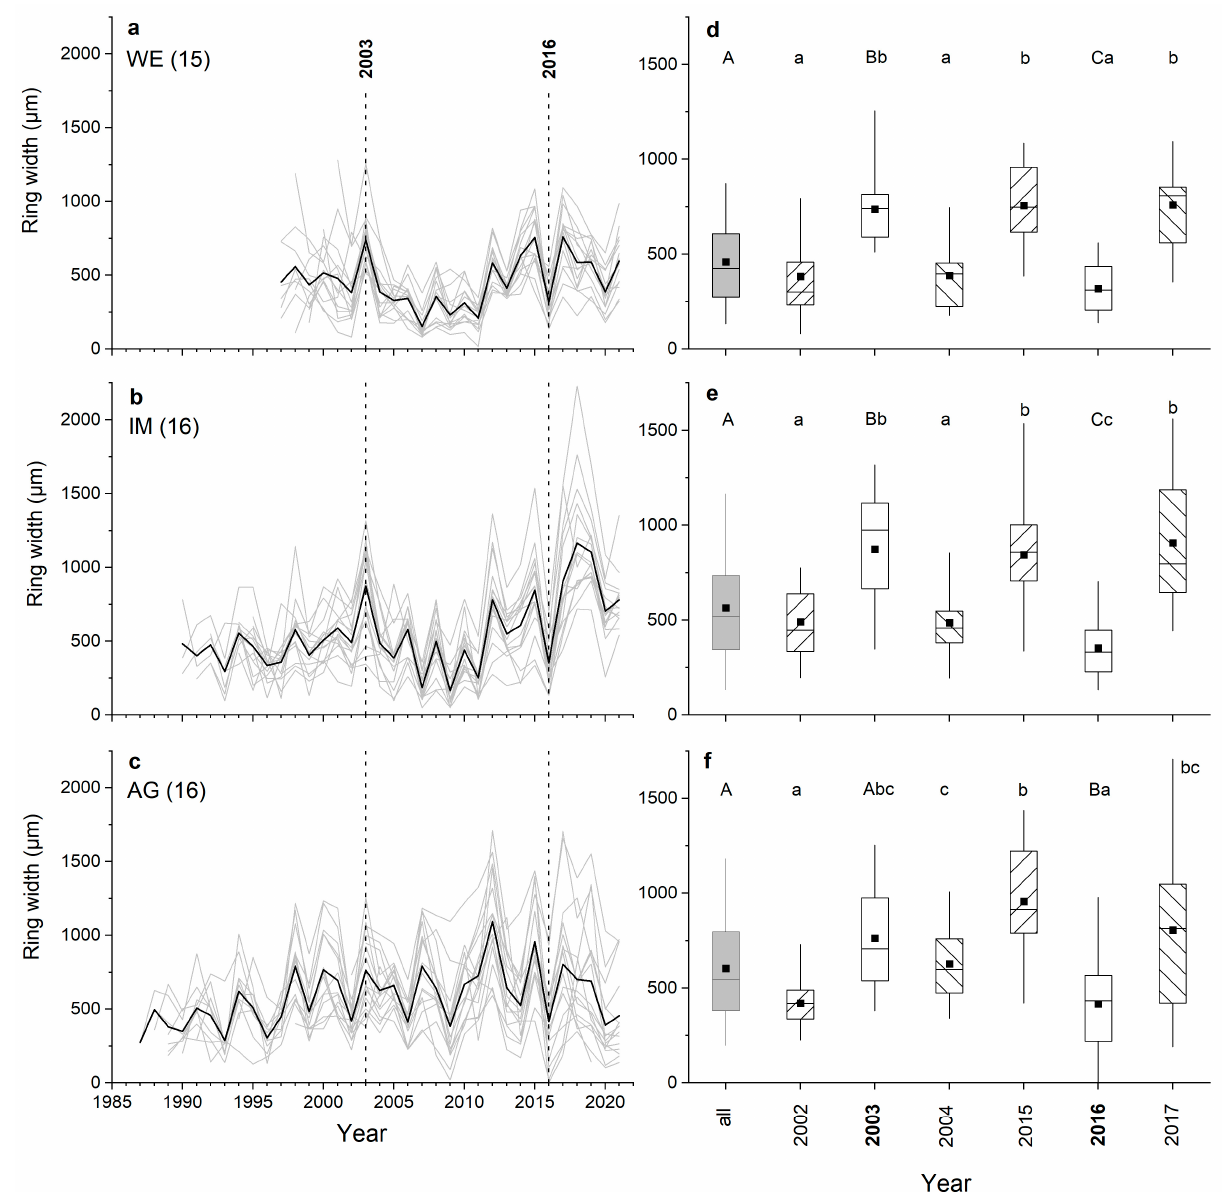
Figure 6. Ring-width series ( a – c ) of all radii (i.e., mean values of radii a , b , c and d ) of all shoots taken from one individual (grey lines; number of shoots measured per stock are given in brackets) at a wind-exposed ridge (site WE), an intermediate site (IM) and a north-facing avalanche gully (site AG). Mean values of all shoots are given as black lines. Vertical dashed lines indicate exemplary extreme growth years: 2003 and 2016 show growth increase and decrease, respectively. Box-plots ( d – f ) showing ring-width variability in all years and in 2003 and 2016; the la tt er two cases include the previous and subsequent year. Statistically signi fi cant di ff erences between (i) mean ring widths of all years and extreme growth years (2003, 2016) are indicated by upper case le tt ers, and (ii) mean ring widths of extreme growth years and the preceding and subsequent year by lower case le tt ers ( p ≤ 0.001; Student’s t -test). For details on box-plots, see Figure 2.